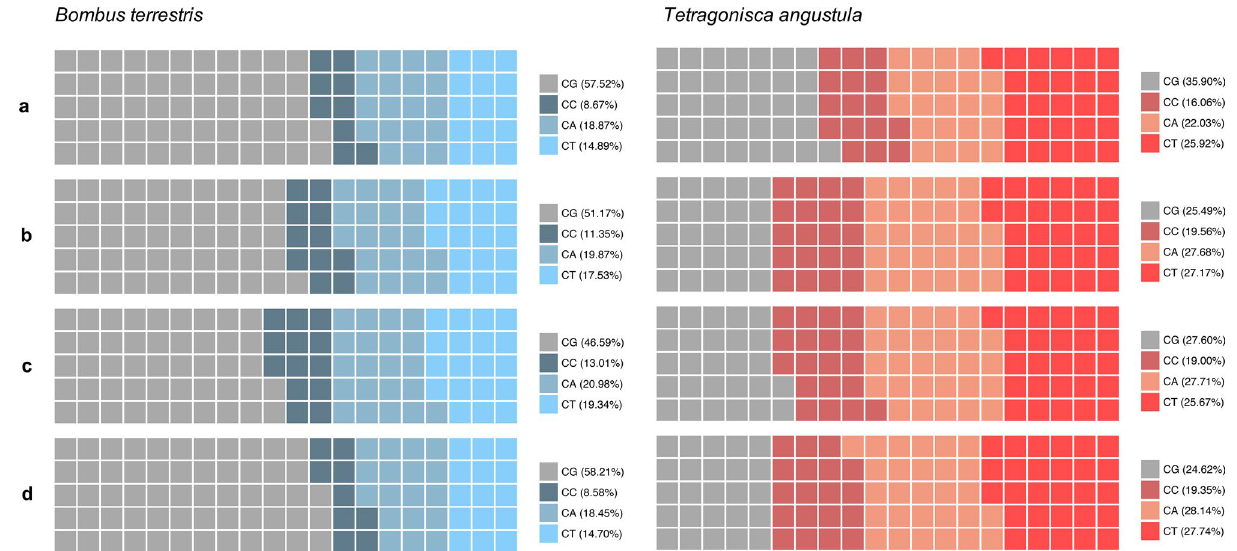
Figure 2. Nucleotide context in which the methylated cytosines occur proportionally to all methylated cytosines reported in nurses of B. terrestris and T. angustula , in distinct gene sets. a in the entire transcriptome; b in the differentially expressed superTranscripts between foragers and nurses; c in the superTranscripts with higher expression levels in foragers; d in the superTranscripts with higher expression levels in nurses. Gray squares represent methylation at the CG context; methylation in non-CG context is illustrated in different shades of blue for B. terrestris and shades of red for T. angustula . One square ≈ 1%, and considering all of the mC reported sums up to 100%.